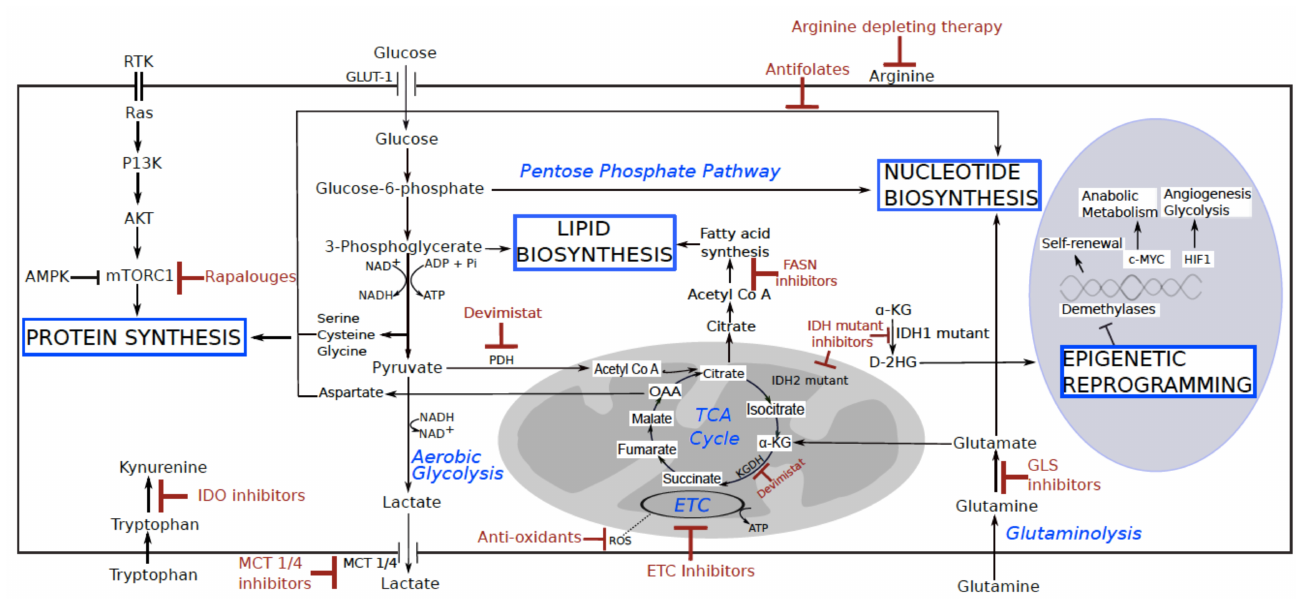
Figure 3. Targeting metabolic reprogramming in cancer. In a fast proliferating cancer cell, energy is most often produced simultaneously by both glycolysis and oxidative phosphorylation. High glucose uptake sustains increased glycolytic rates required for macromolecule biosynthesis (proteins, lipids and nucleotides), furthermore fueled by TCA cycle intermediates that can be replenished by the use of glutamine as carbon and nitrogen source. In certain cancers, the atypical accumulation of oncometabolites, such as D-2HG, may promote epigenetic remodeling. The main cellular pathway regulating metabolic reprograming is mTORC1, whose activity regulates several transcription factors to promote glycolysis and macromolecule biosynthesis. These reactions have been recognized as valid targets for cancer treatment and some of the current metabolic anti-cancer strategies are indicated in